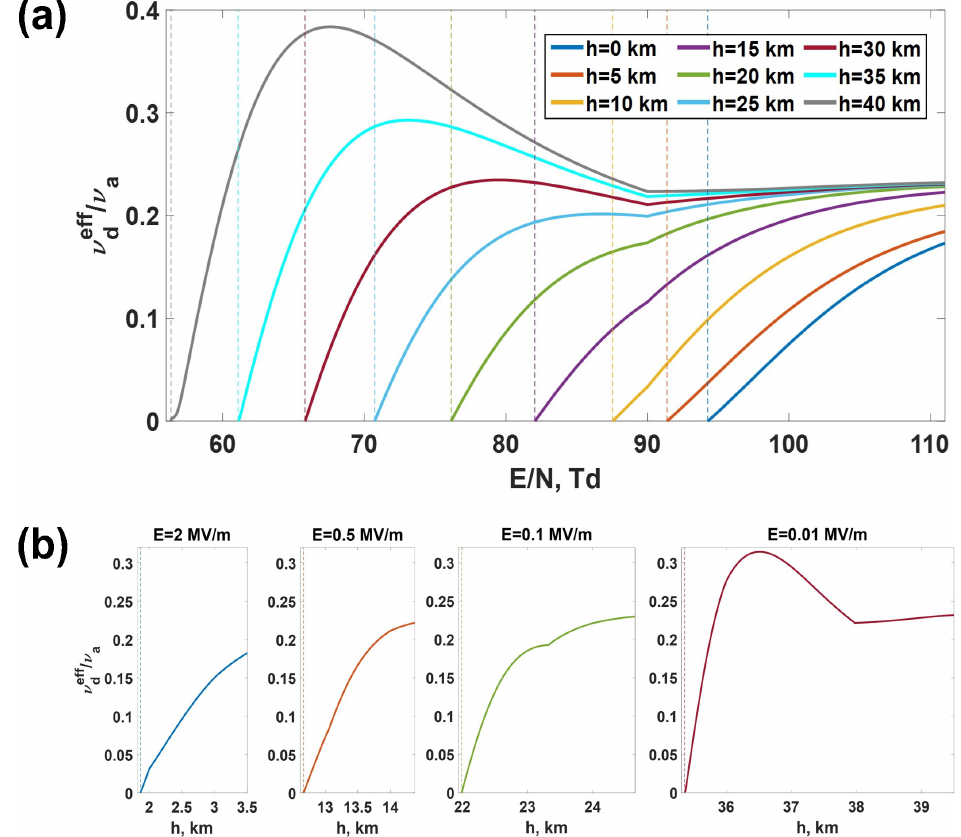
Figure 6. Dependence curves of the ratio ν eff / ν a on ( a ) reduced electric field E / N for different d altitudes AMSL and ( b ) on altitude h for several fixed values of E . Vertical dashed lines stand for reduced critical electric fields E c / N (in panel ( a )) and altitudes (in panel ( b )) at which the discharge development